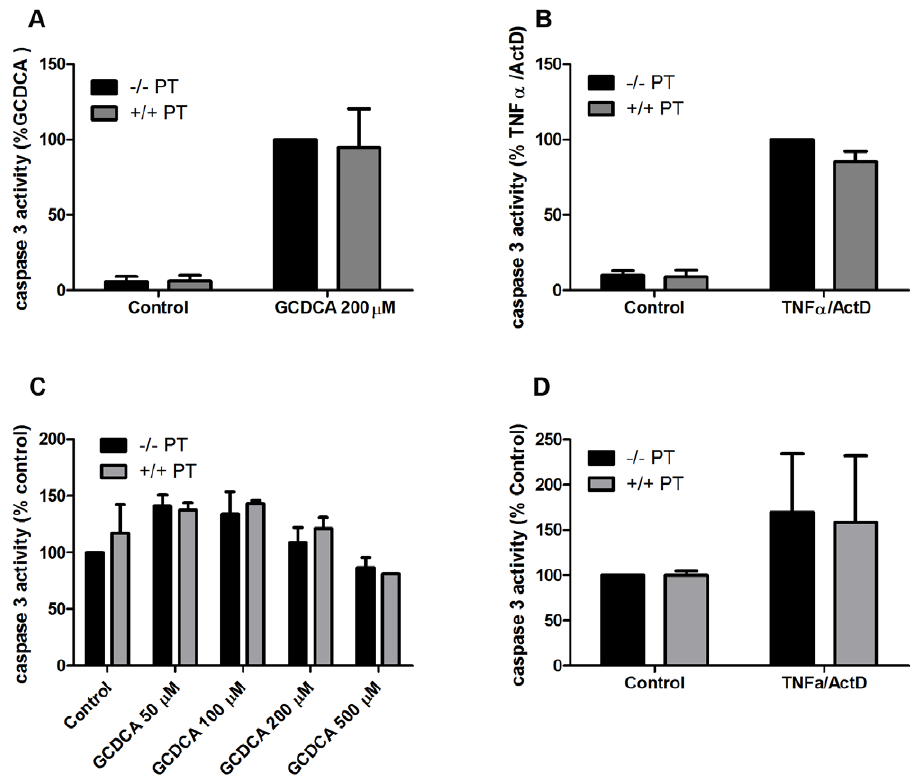
Figure 5. Pertussis toxin (PT) does not inhibit apoptosis in HepG2-rNtcp cells and rat H-4-II-E cells. ( a ) Caspase-3 activity in HepG2-rNtcp cells treated with 200 m mol/L of GCDCA in the presence and absence of 200 nmol/L PT. ( b ) HepG2-rNtcp cells were treated for 16 hours with 20 ng/ ml of TNF a in the presence of 200 ng/ml of ActD. 200 nmol/L of PT was added 30 min prior to the addition of TNF a /ActD. ( c ) Caspase-3 activity in rat H-4-II-E cells treated with 50–500 m mol/L of GCDCA in the presence and absence of 200 nmol/L PT. ( d ) Rat H-4-II-E cells were treated for 16 hours with 20 ng/ml of TNF a in the presence of 200 ng/ml of ActD. 200 nmol/L of PT was added 30 min prior to the addition of TNF a /ActD.